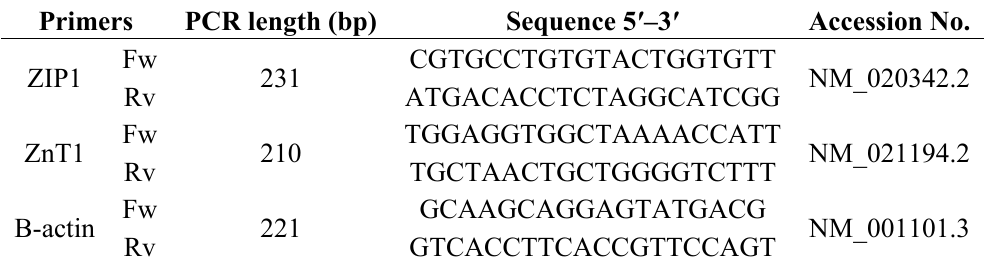
Table 1. Primers used for relative gene expression